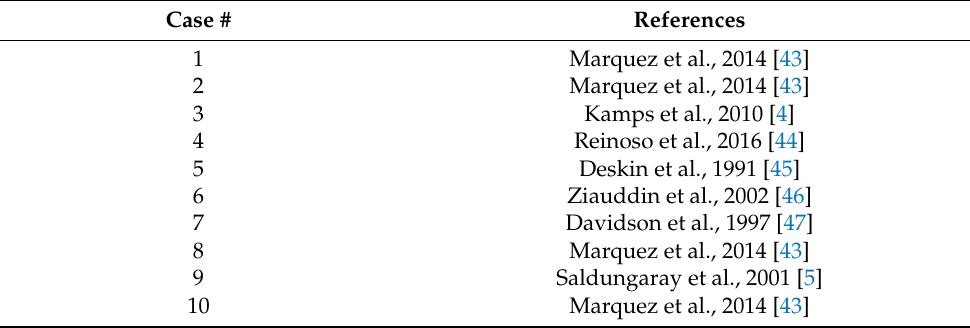
Table 3. The literature sources for production-well histories under fines migration.